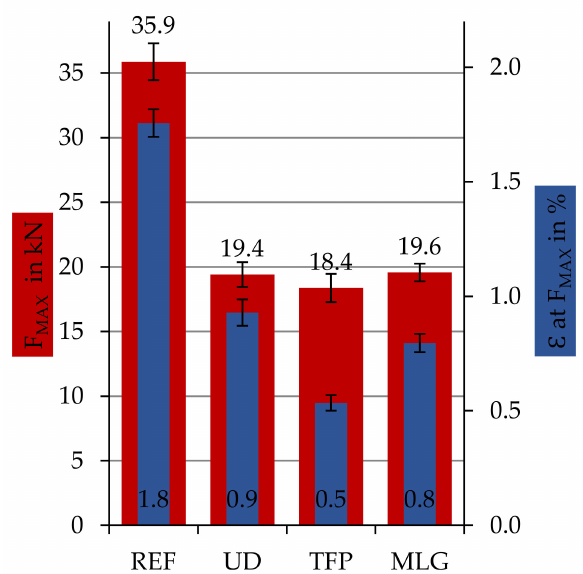
Figure 7. Specific values of damaged samples, repaired with different patch materials—cut UD material (UD), patches manufactured by tailored fiber placement (TFP), patches manufactured by multilayer weft knitting (MLG) compared to the reference samples without any defect.